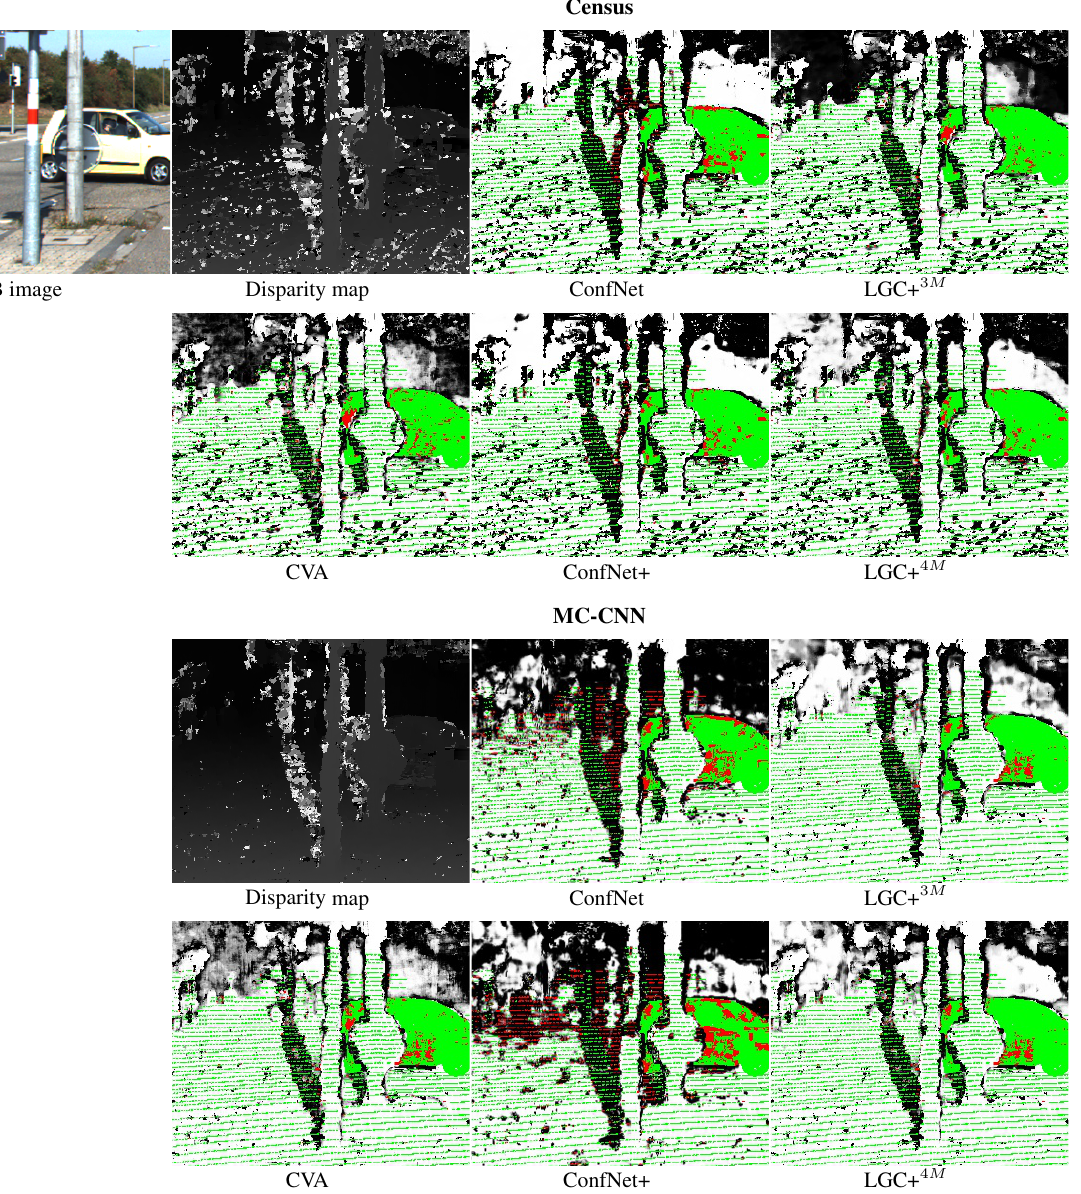
Figure 4. Qualitative evaluation regarding the generalization capabilities of the proposed approach on the KITTI 2015 dataset (Menze and Geiger, 2015). For details on colour coding, please refer to Figure